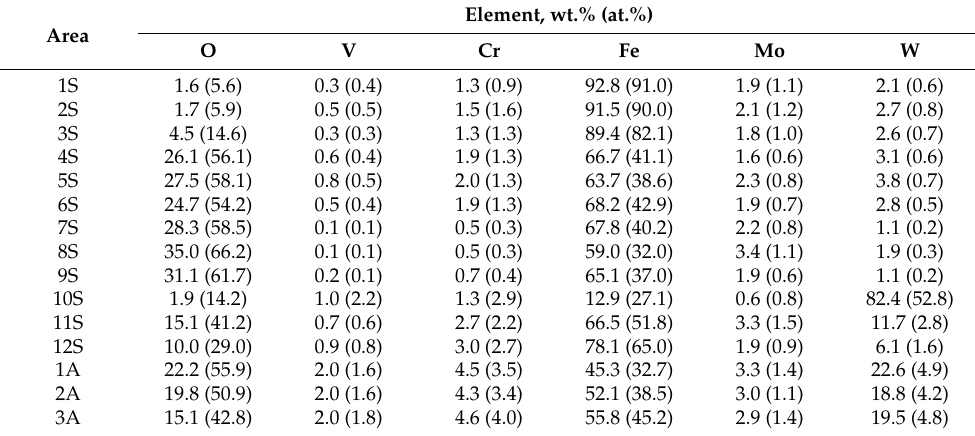
Table 5. EDS chemical composition of the M2/W worn surface on sliding at 3.6 m/s (Figure 12f).